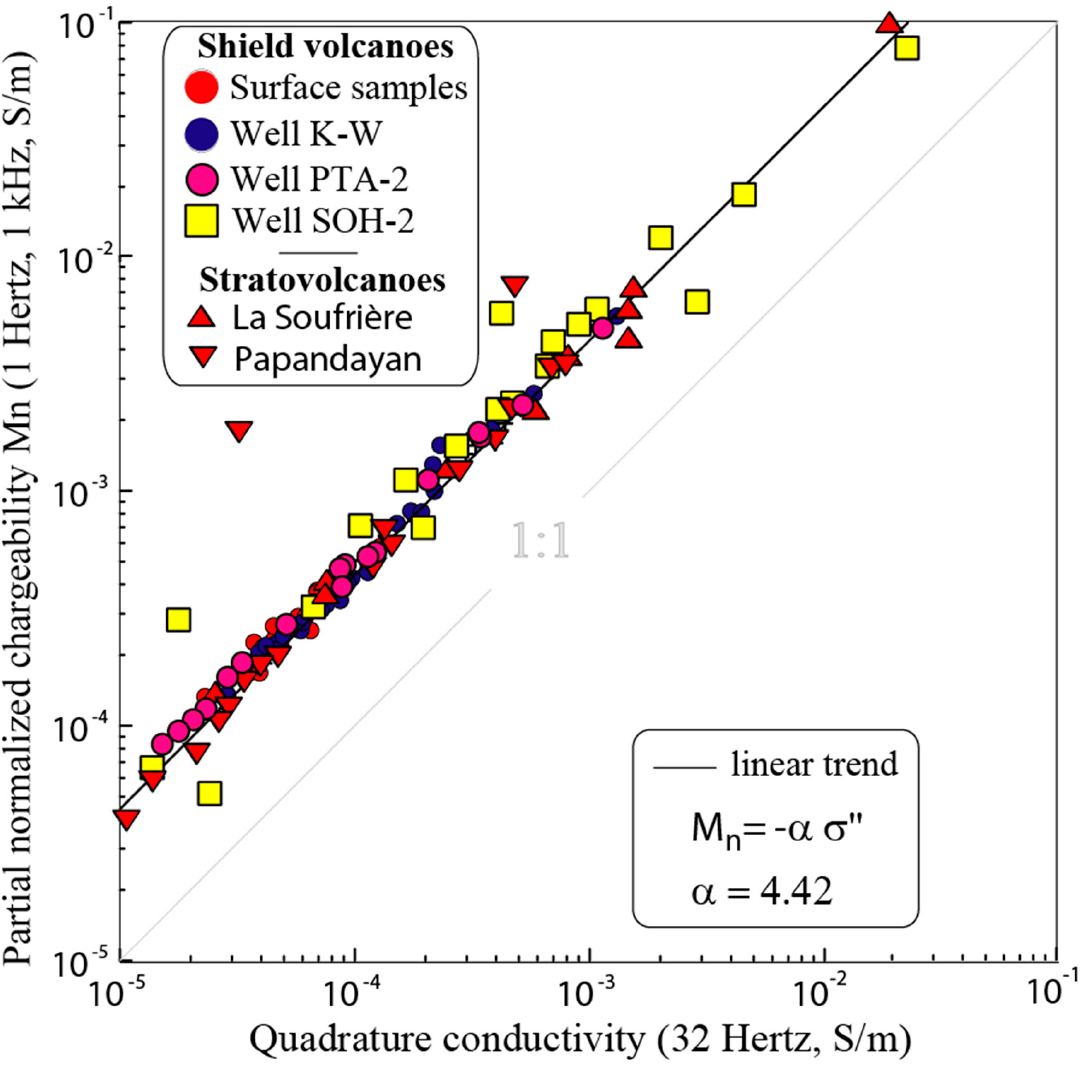
Figure 21. Normalized chargeability (1 Hertz ‐ 1 kHz) versus the quadrature conductivity for the volcanic samples from Hawaii (low salinity, NaCl, 25 °C). The “partial” normalized chargeability is determined as the difference in the in ‐ phase conductivity between two frequencies (1 Hz and 1 kHz), while the quadrature conductivity is determined at the geometric mean frequency of 32 Hz. The plain line corresponds to a linear trend. The theory predicts that this trend is independent of the presence of magnetite (or pyrite) in the rocks. There are 93 samples in total for the shield volcanoes in Hawaii, and 32 additional samples from La Soufrière and Papandayan volcanoes. The value of the coefficient ( α ) can be predicted from the theory (unpublished results).